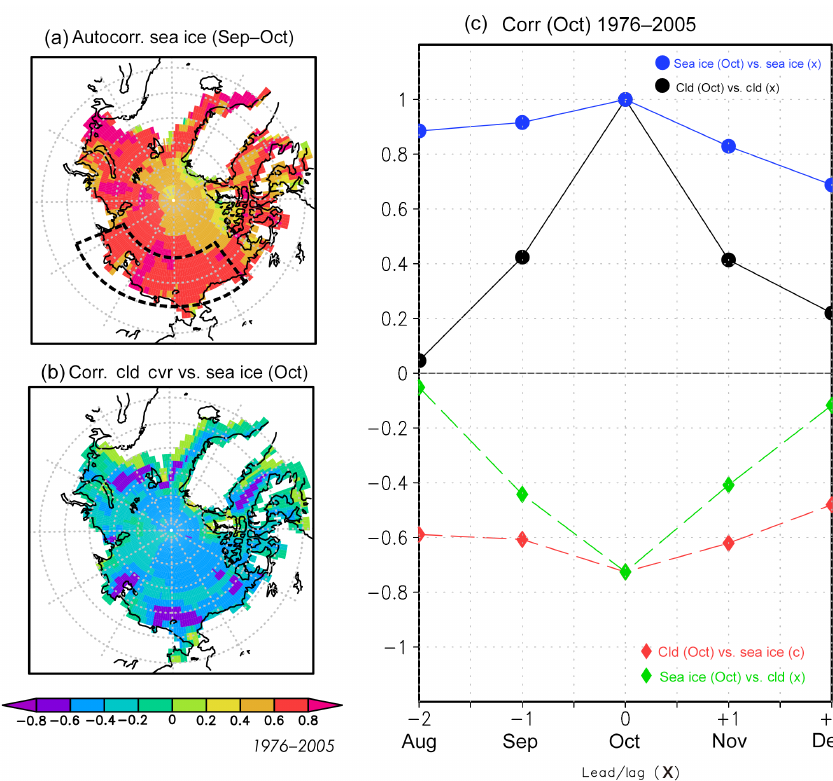
Figure 4. (a) Autocorrelation coefficients in the sea ice concentration between September and October in the MIROC5 simulations. (b) Cor- relation coefficients between cloud cover and sea ice concentration in October in the MIROC5 simulations. (c) Autocorrelation (closed circles) in the sea ice concentration (blue solid lines) and cloud cover (black solid lines), correlations (closed diamonds) in the lead/lagged sea ice concentrations and October cloud cover (green broken lines), and correlations in the October sea ice concentration and lead/lagged cloud cover (red broken lines) in the MIROC5 simulations. The correlation coefficients were calculated using averages for the boxed region shown in (a)